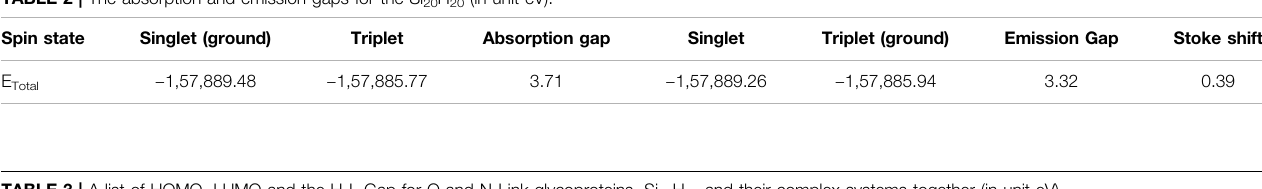
TABLE 3 | A list of HOMO, LUMO and the H-L Gap for O and N-Link glycoproteins, Si 20 H 20 and their complex systems together (in unit eV). Structures